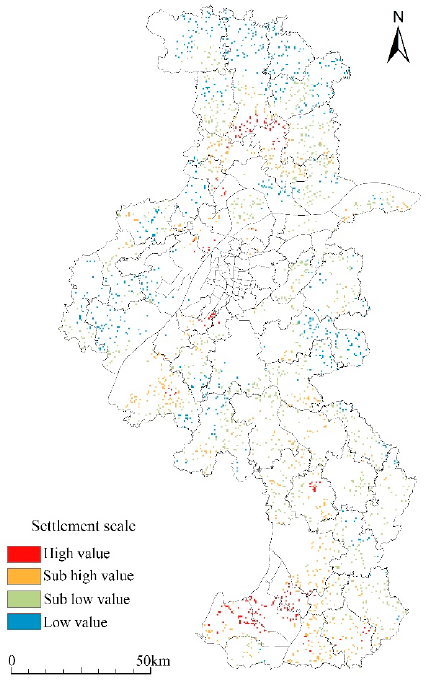
Figure 5. Hot spots pattern of rural settlements scale in Nanjing. Table 1. Fitting parameters of variation of rural settlement morphology distribution.